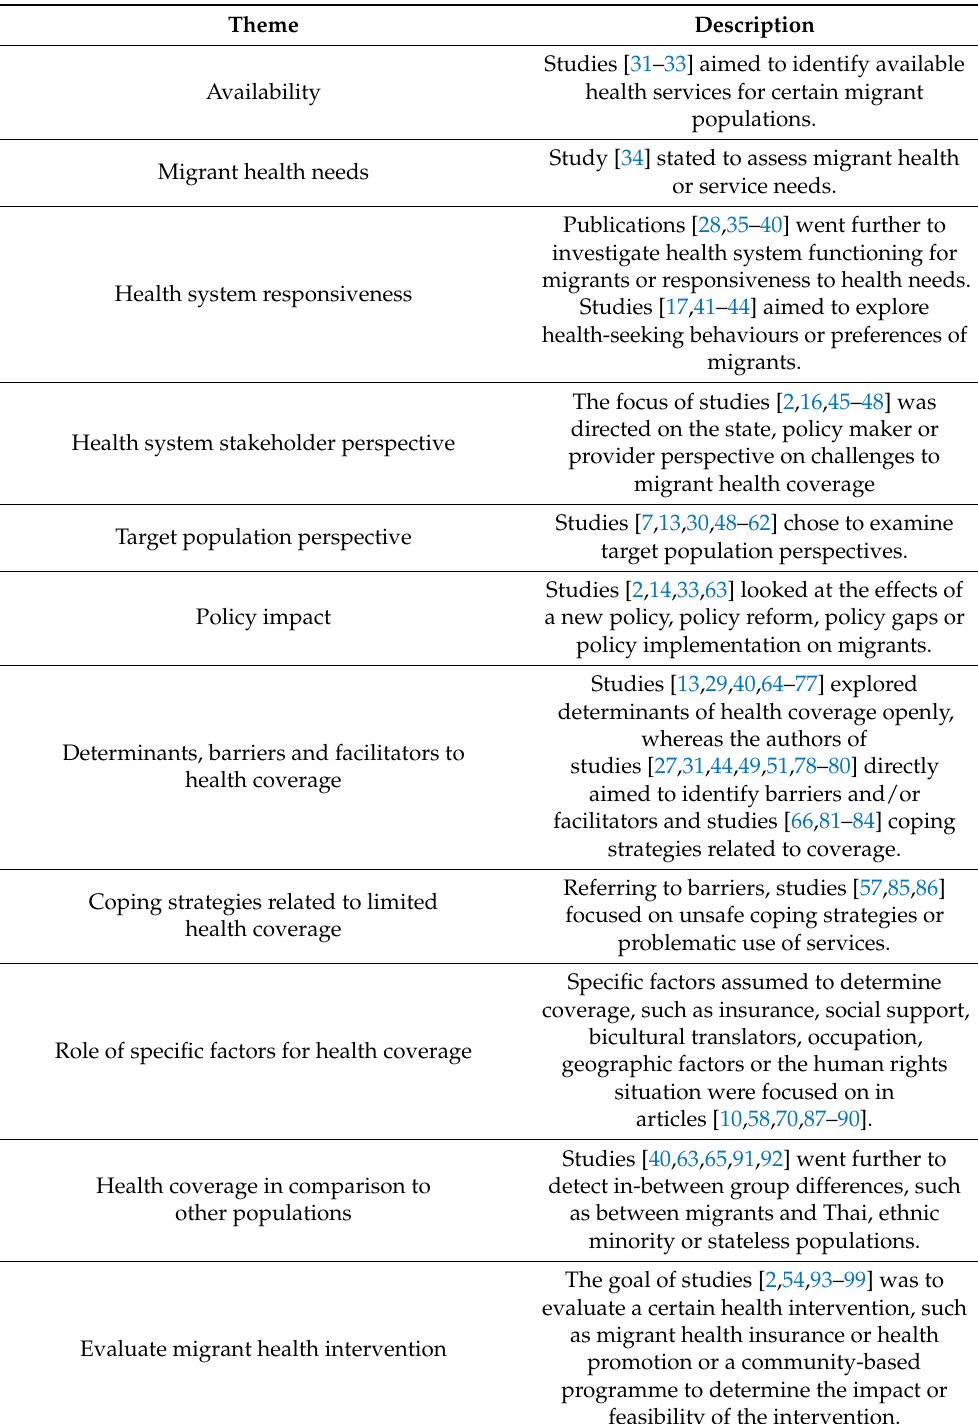
Table 1. Objectives of included studies—Themes derived from content